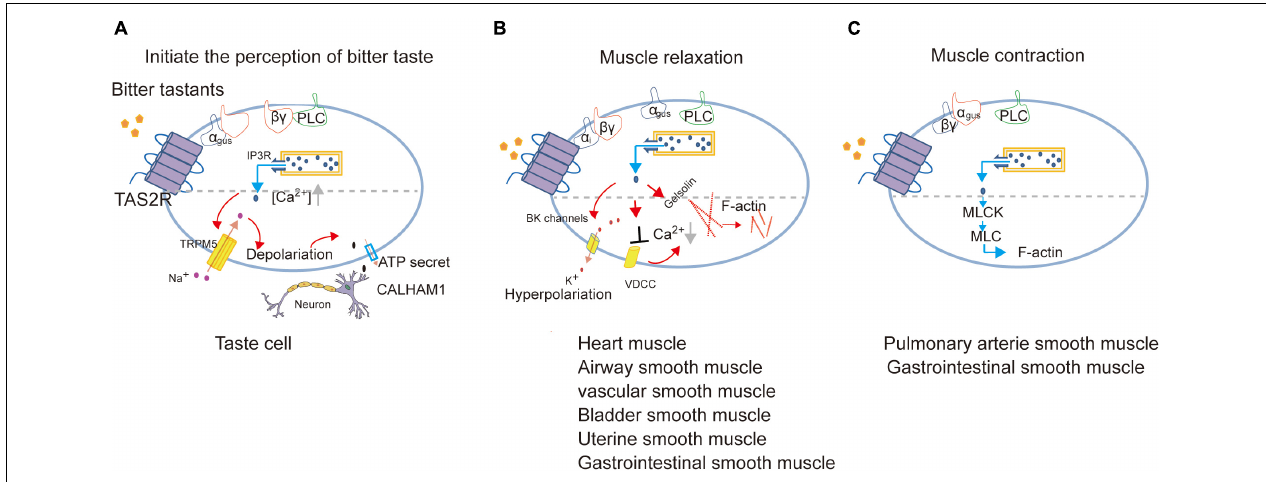
FIGURE 3 | Proposed model of signal transduction of TAS2Rs in different cell types to mediate the perception of bitter taste (adapted from Behrens and Meyerhof, 2015; Avau and Depoortere, 2016; Shaik et al., 2016; Lu et al., 2017) (A) , muscle relaxation (adapted from Zhai et al., 2016; Kim et al., 2017; Pan et al., 2017; Zheng et al., 2017; An and Liggett, 2018; Scadding, 2018) (B) or muscle contraction (adapted from Upadhyaya et al., 2014; Avau et al., 2015) (C)